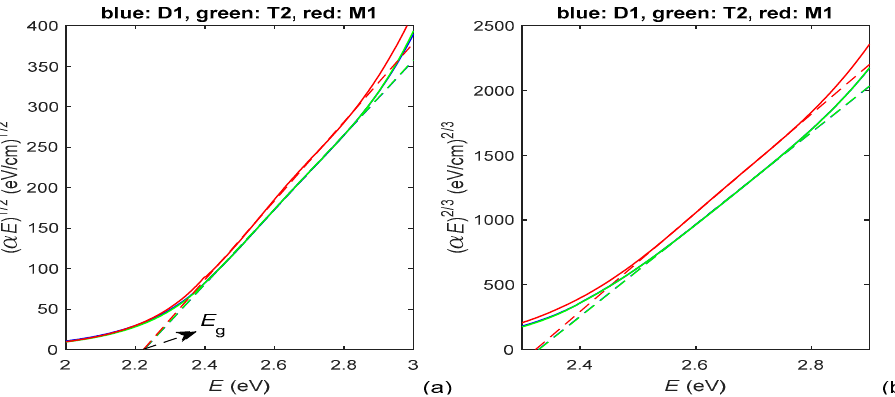
Figure 5. ( a ) Tauc plot for p = 2, utilizing k ( E ) from Figure 2b, for the PAZO polymer films; ( b ) Tauc plot for p = 3/2, utilizing k ( E ) from Figure 2b, for the same films. The straight line approximations are depicted by dashed lines.